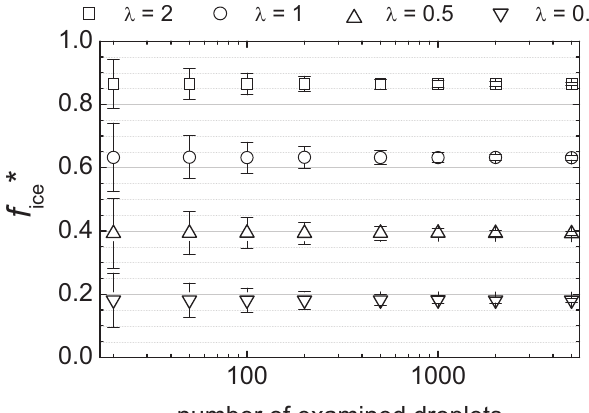
Figure 2. Average f ∗ and the respective standard deviation for ice different numbers of examined droplets and for different values of λ , obtained by theoretical